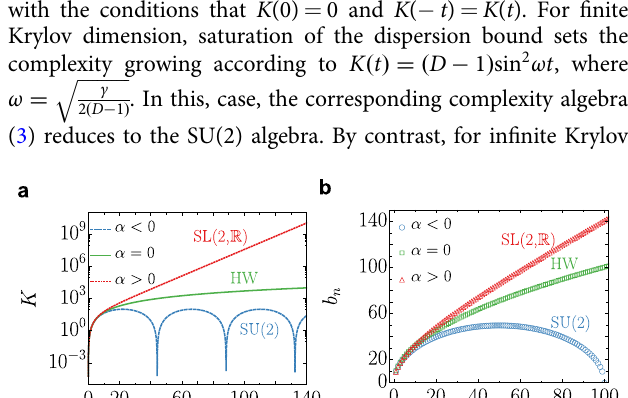
ffiffiffiffiffiffiffiffiffiffiffiffiffiffiffiffiffiffiffiffiffiffiffiffiffi p h A 2 i (cid:3) h A i 2